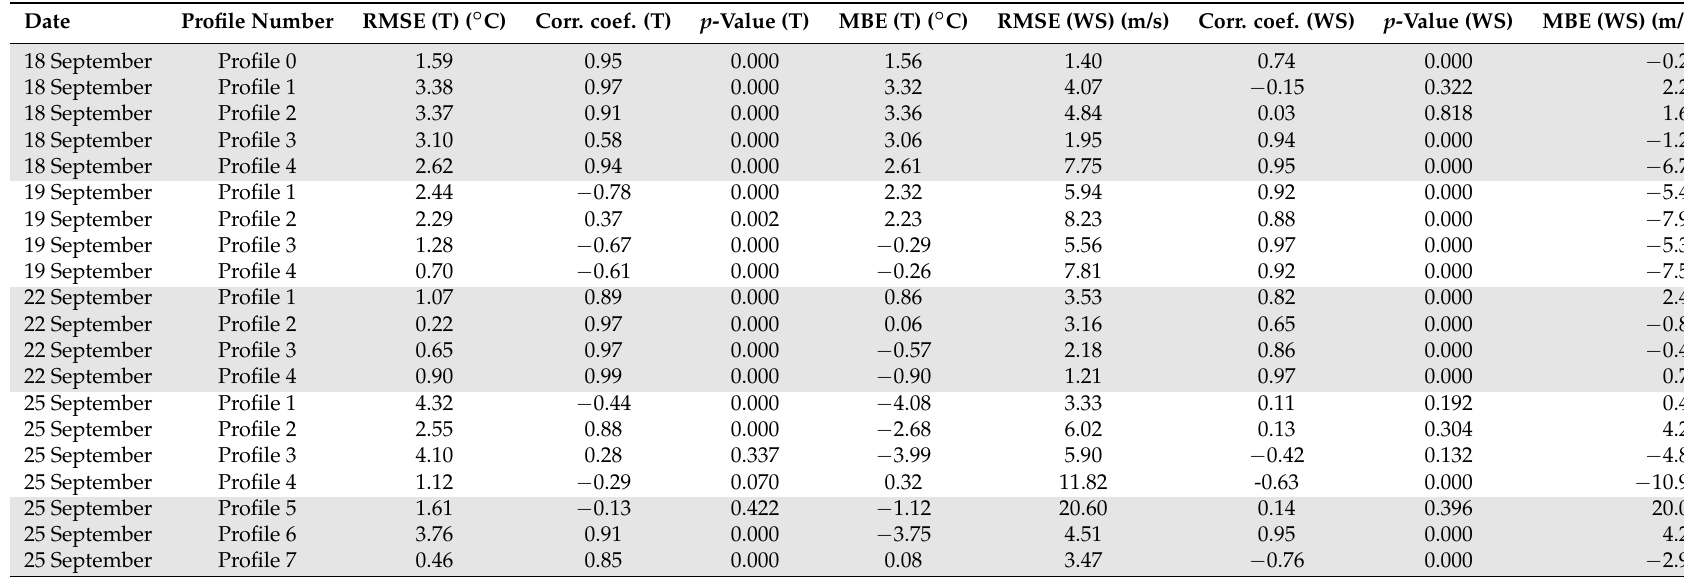
Table 4. Statistics for the comparison of AMPS results and UAS Aerosonde profiles in the middle layer of the atmosphere (500–1000 m). T—temperature, WS—wind